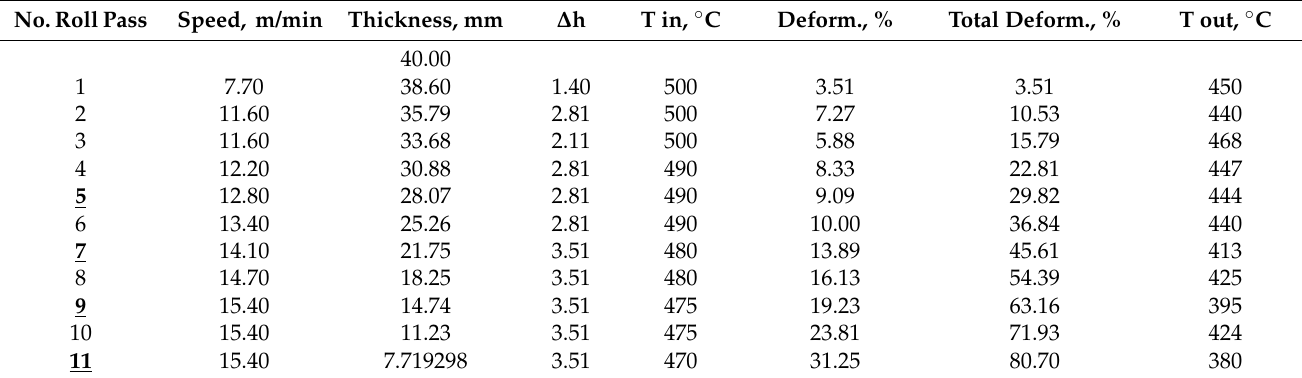
Table 4. Actual rolling parameters of 8011